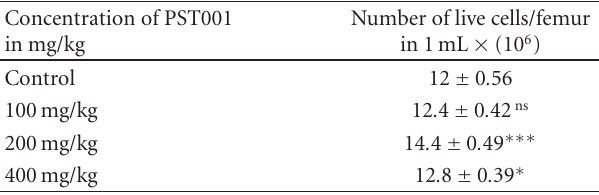
Table 8: E ff ect of PST001 on bone marrow